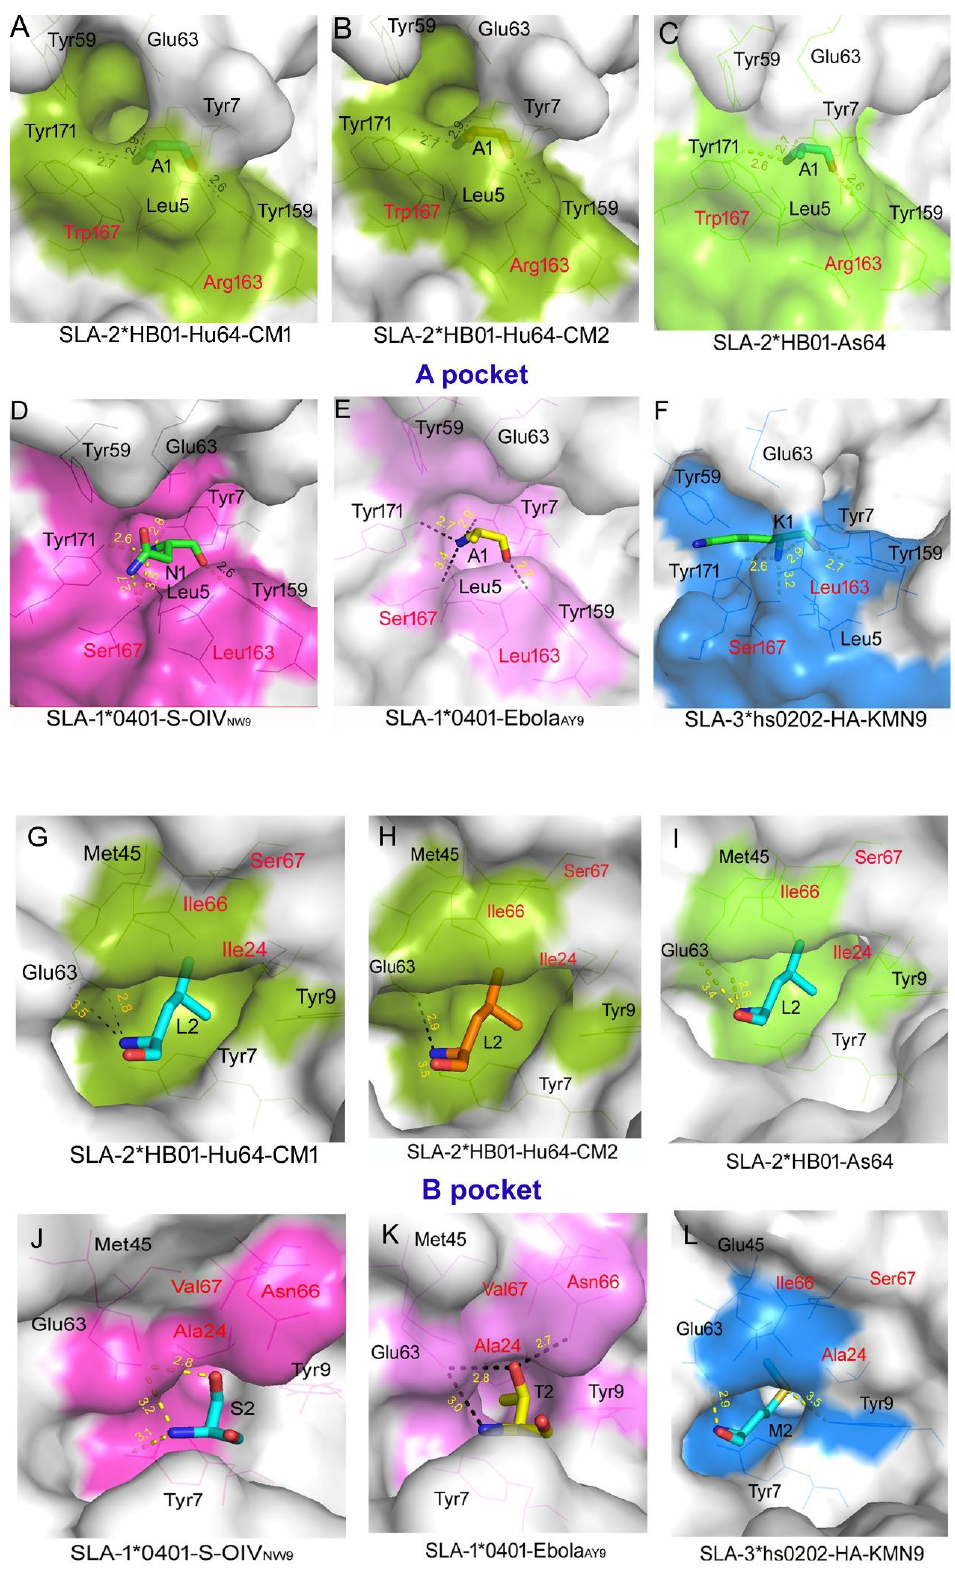
Figure 4. Comparison of pockets A and B in SLA-2*HB01, SLA-1*0401, and SLA-3*hs0202. Pockets are shown as surface representations in white color. The residues comprising the pocket are shown as lines. The residues labeled in black are conserved (no mutation in the above molecules), whereas